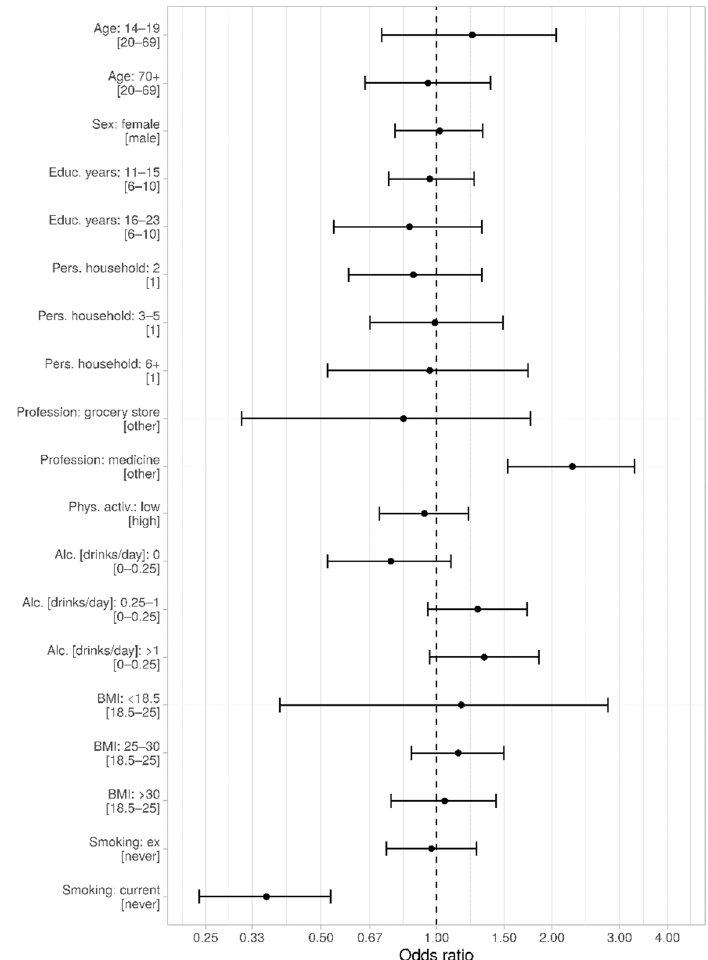
Figure 5. Association of demographic and life style factors with seropositivity. Odds ratios including the 95%-CI are indicated, respectively. p < 0.001 (***). Analysis was conducted in R (R Core Team (2020). R: A language and environment for statistical computing. R Foundation for Statistical Computing, Vienna, Austria. URL http://www.R-project.org/). This figure was produced using the package ggplot2 (Wickham, H. (2009) ggplot2: elegant graphics for data analysis. Springer New